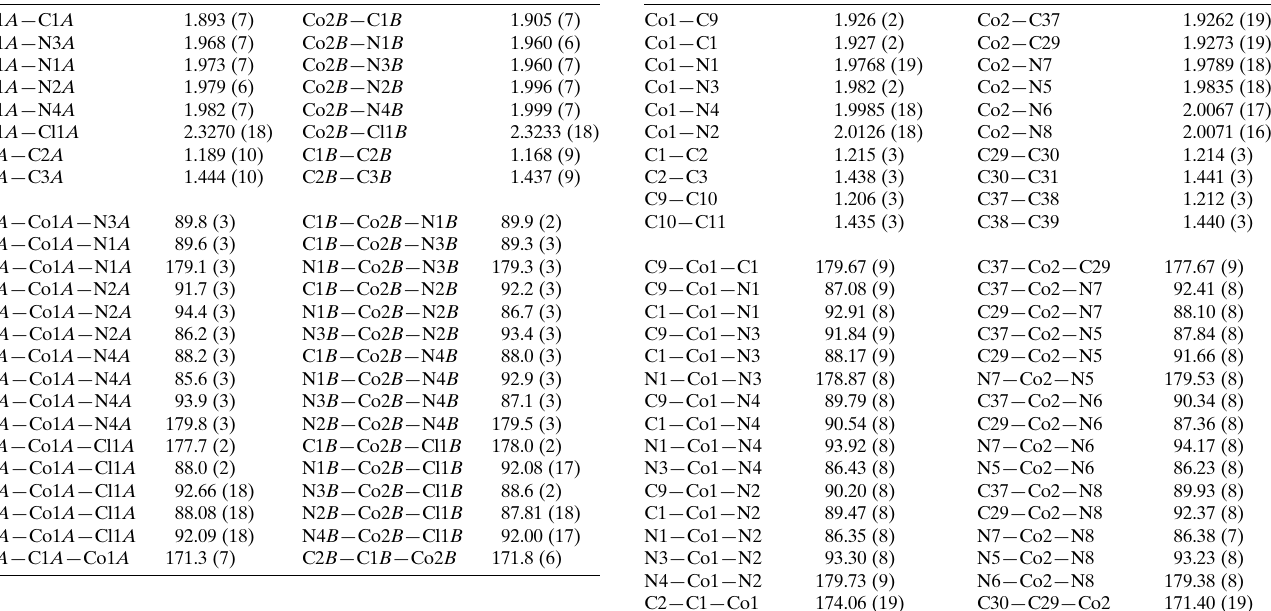
Table 1 Selected geometric parameters (A˚ , (cid:3) ) for 1 .